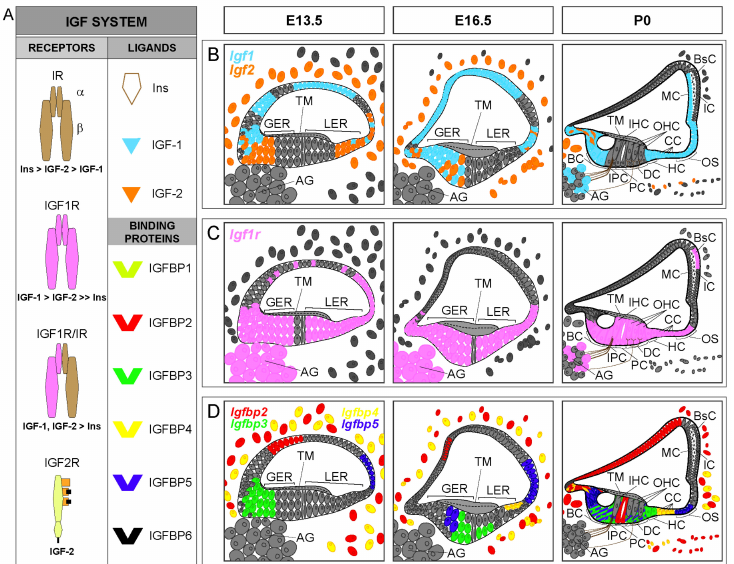
Figure 1. IGF system expression patterns in the developing cochlea. ( A ). Schematic representation of the IGF system and receptors binding affinity. The IGF system consists of three ligands (insulin,